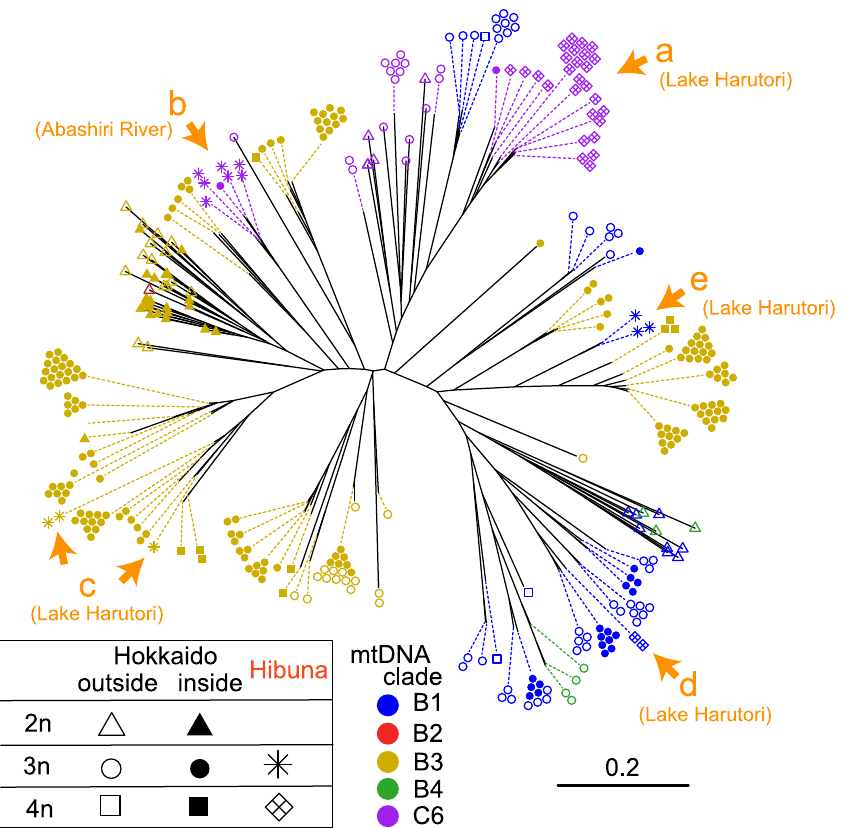
Fig 3. NJ tree based on the genetic distance between 358 individuals constructed using Bruvo’s distance obtained from seven microsatellite loci. For the specimens collected on Hokkaido including Hibuna, triploid and tetraploid individuals of identical genotypes were aligned on the corresponding tips. Clusters of Hibuna specimens are labeled as a–e with their sampling locality in orange. The triangular, circular, and square shapes at the tip represent diploid, triploid, and tetraploid, respectively, whereas the open or closed symbols indicate sampling regions outside and inside of Hokkaido, respectively. Asterisks and diamond crosses represent triploid and tetraploid Hibuna, respectively. The colors of symbols correspond to mitochondrial lineages of